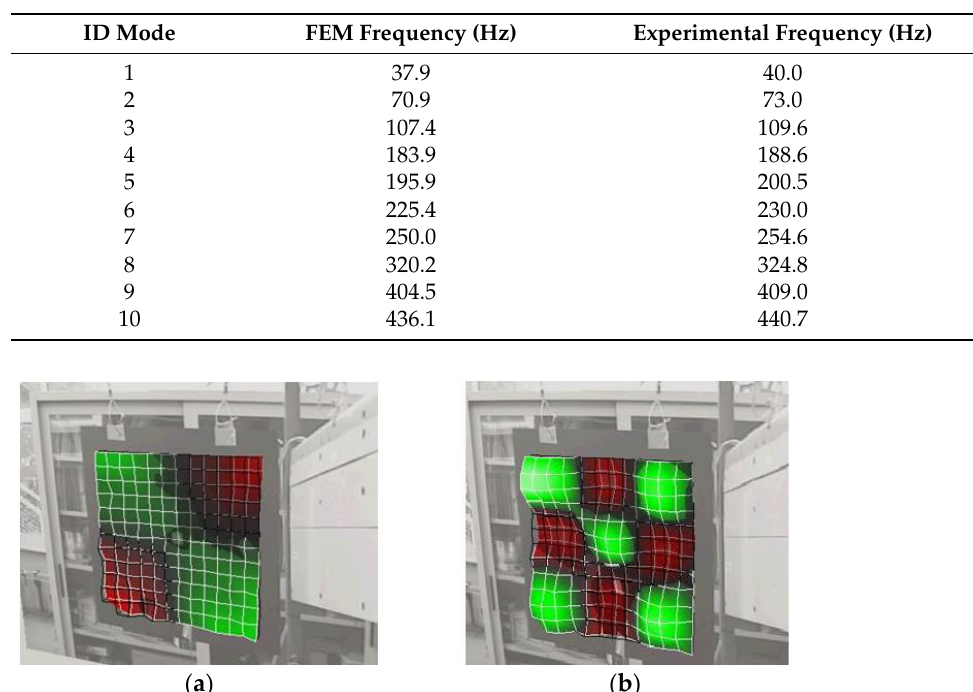
Table 2. Natural frequencies comparison among first 10 mode shapes.